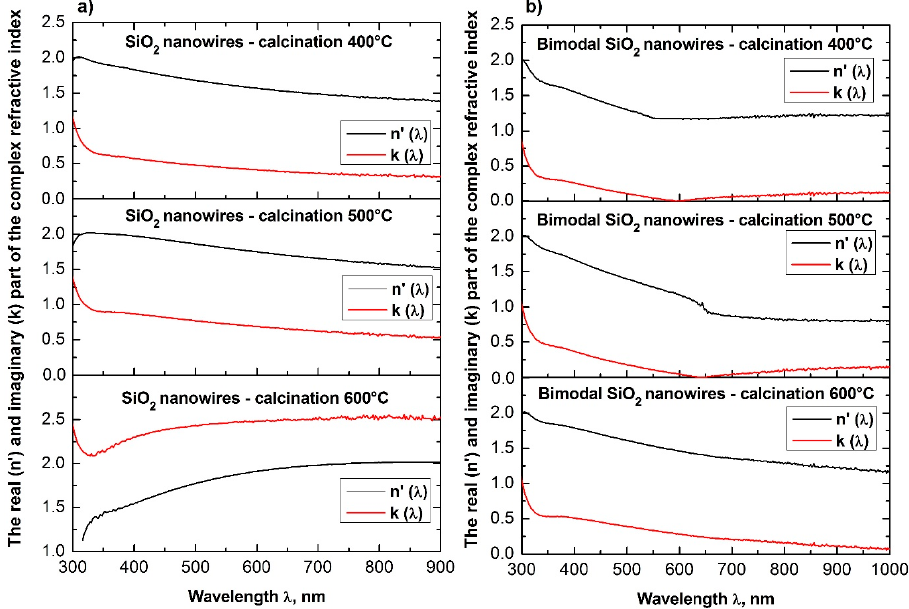
Figure 12. Dependences of the real n ′ ( λ ) ( a ) and imaginary k ( λ ) parts ( b ) of the refractive index